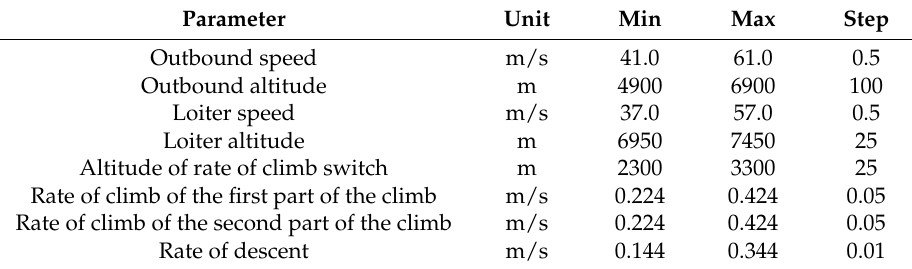
Table 6. Mission design variables for the MALE-UAV’s